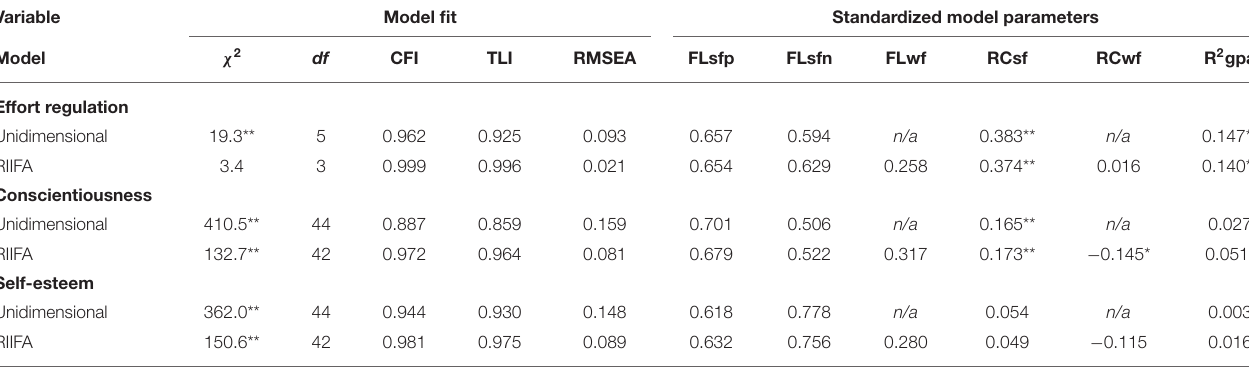
TABLE 3 | Parameter estimates for the predictive SEM models of grade point